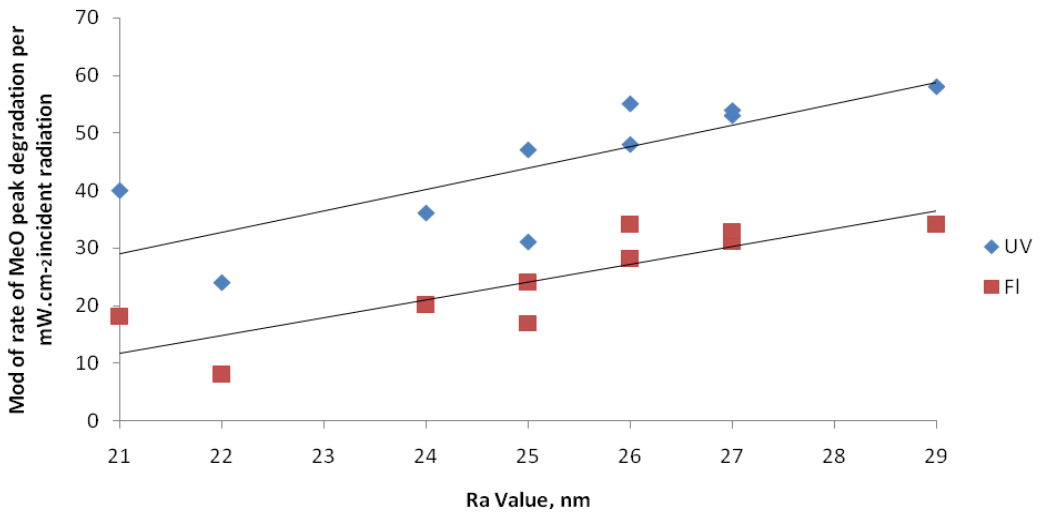
Figure 6. Comparison of normalized methyl orange degradation rates (*1000) with exposure to UV or fluorescent lamps as a function of R